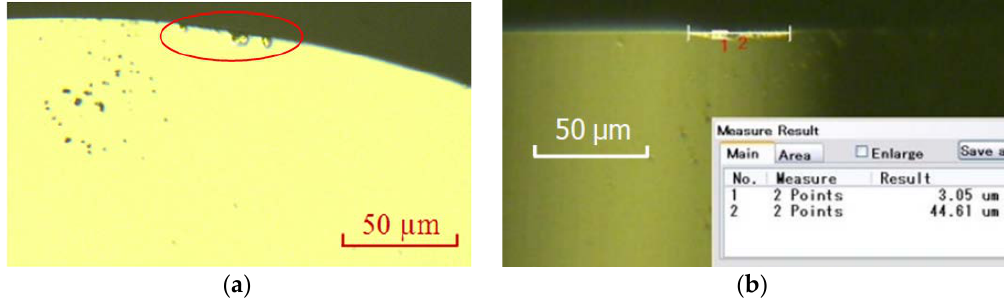
Figure 11. Wear of diamond tool with tip radius of 0.5 mm after cutting along X -axis with a distance of 1 mm (wear land width: 3.05 µm, wear land length: 44.61 µm); ( a ) Wear of rake face; ( b ) Wear of rear face. Micromachines 2018 , 9 , x FOR PEER REVIEW